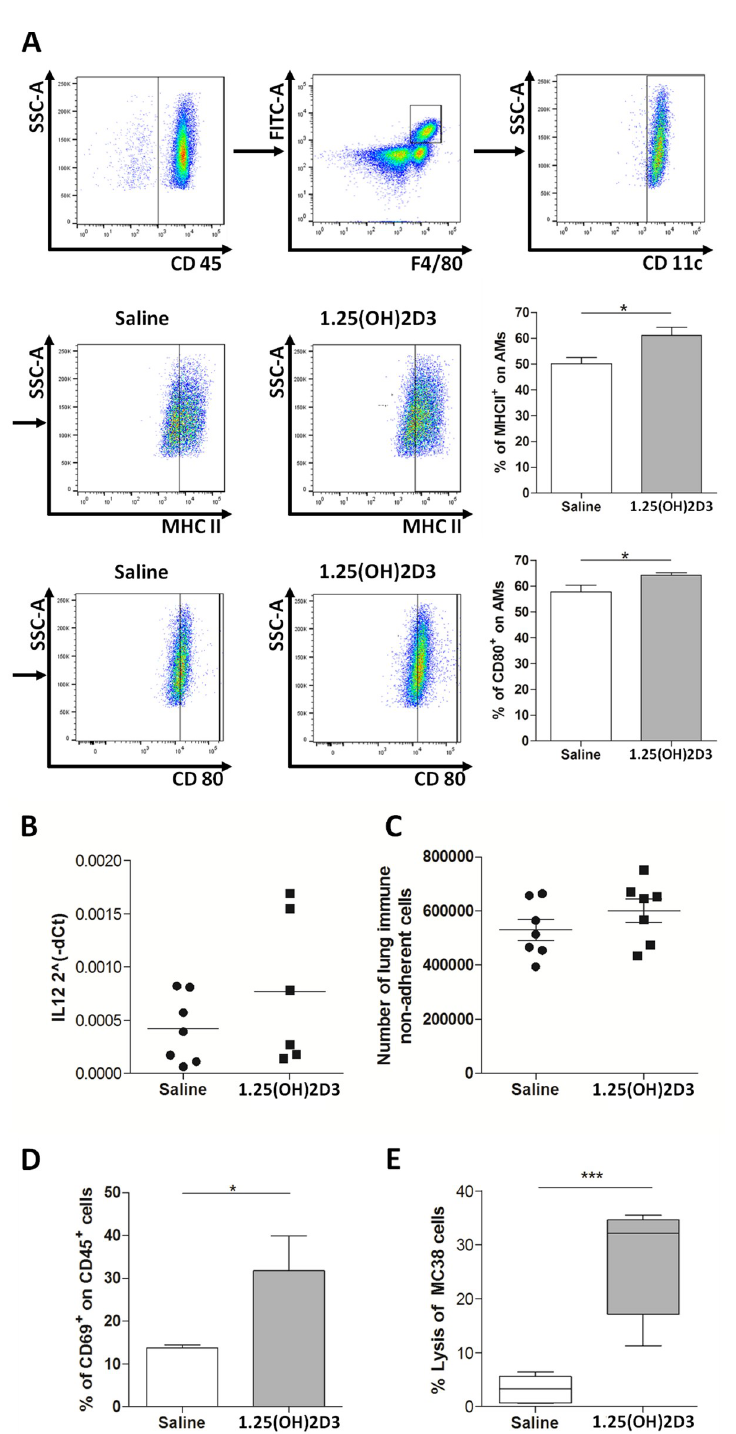
Fig 4. 1,25(OH)2D3 aerosolization induces activation of innate immune effectors in the lung. Lungs were recovered from tumor-bearing mice treated with 1,25(OH)2D3 or saline. Flow cytometry analysis of the expression of MHCII and CD80 maturation markers on AM of lungs digestion (A). Real time PCR analysis of IL-12 mRNA expression in adherent fraction from lung suspensions (B); count of cells in the non-adherent fraction containing effector cells from lung suspensions (C); flow cytometry analysis of CD69 activation marker on the non-adherent fraction (D); percentage of MC-38 lysated cells evaluated by in vitro cytotoxic assay performed with non-adherent fractions from lung suspensions (E); Unpaired t test; ��� p < 0.0001.